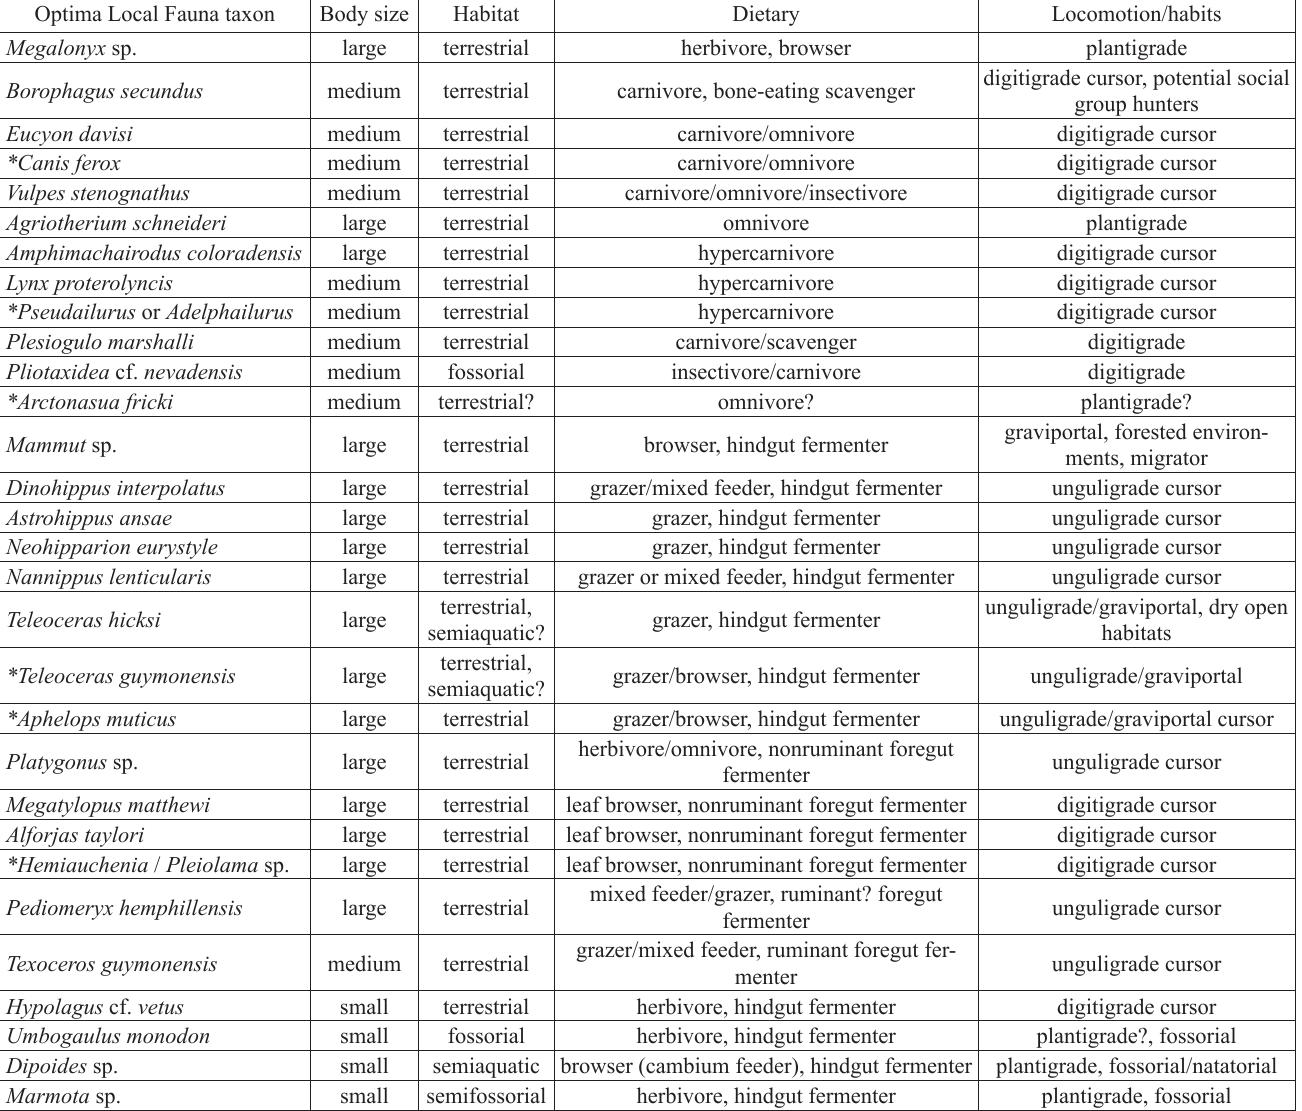
Table 2. Ecomorphological attributes of mammals of the Optima Local Fauna (Miocene, late Hemphillian, Oklahoma, USA) inferred from actu­ alism and by authors of the references: Antón et al. (2013); Baskin (1982); Hoppe et al. (1999); Joeckel and Tucker (2013); Kohn et al. (2005); MacFadden (2000, 2005); McDonald (2005); Mihlbachler et al. (2011); Passey et al. (2002); Perez­Crespo et al. (2016); Prothero (1998); Rivals et al. (2012); Rybczynski (2007, 2008); Semprebon and Rivals (2007, 2010); Semprebon et al. (2004, 2016); Voorhies and Thomasson (1979); Wang (2016). * taxon not available in OMNH